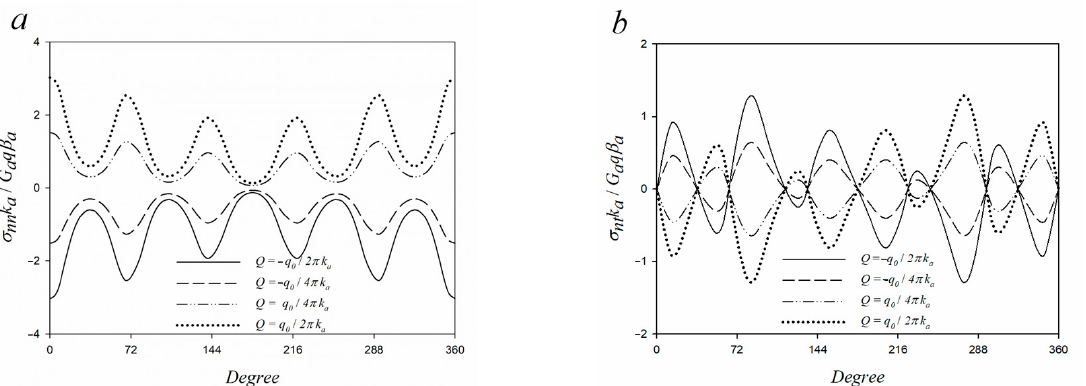
Figure 8. Interfacial ( a ) normal and ( b ) shear stress of a coated pentagonal hole ( w = 0.05 , G b / G a = 3, β b / β b = 3 , k b /k a = 2 , ν b = 0.3 , ν a = 0.3). Table 1. The interfacial normal stress of each corner of the pentagonal hole under different magni- tudes of heat loading.